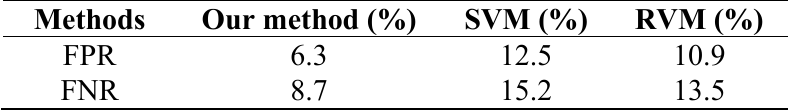
Table 3. Evaluation results with FPR and